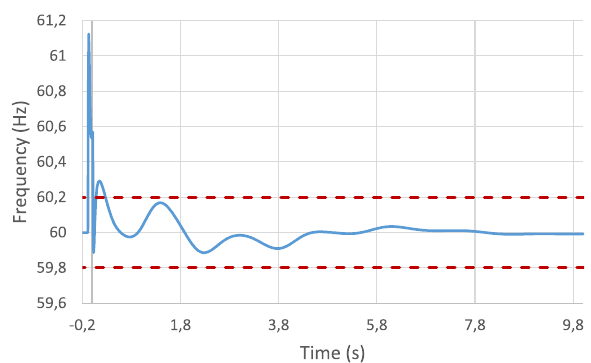
Fig. 4. Evolution of the frequency on bus 19, before, during and after a